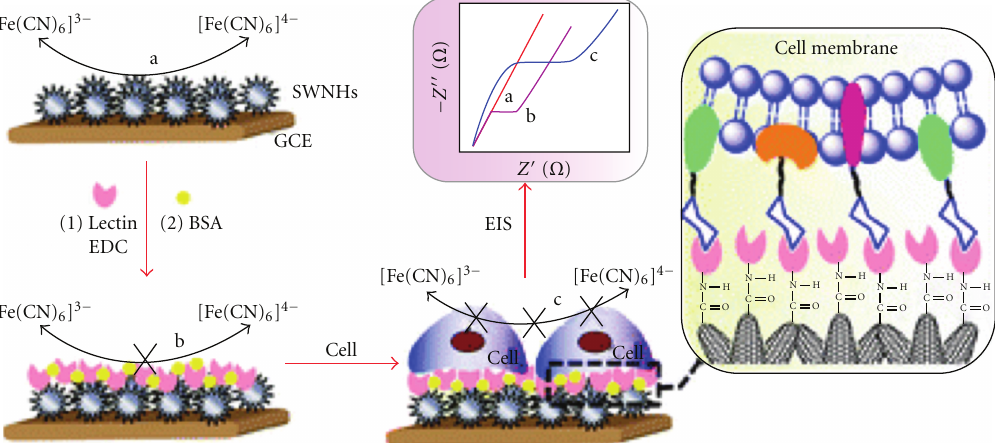
Figure 3: Schematic representation of the electrochemical label-free sensor for the analysis of glycan expression on cell surfaces. The sensor was fabricated by modifying a glassy carbon electrode (GCE) with single-walled nanohorns (SWNHs), followed by the covalent attachment of the lectin to the SWNHs, and blocking by bovine serum albumin (BSA). The specific binding between the lectin and the cell membrane carbohydrate was detected by EIS as an increase in charge transfer resistance in the presence of the redox couple [Fe(CN) 6 ] 3 − / 4 − [18]. Reproduced with the permission of The Royal Society of Chemistry. http://dx.doi.org/10.1039/B918008G.